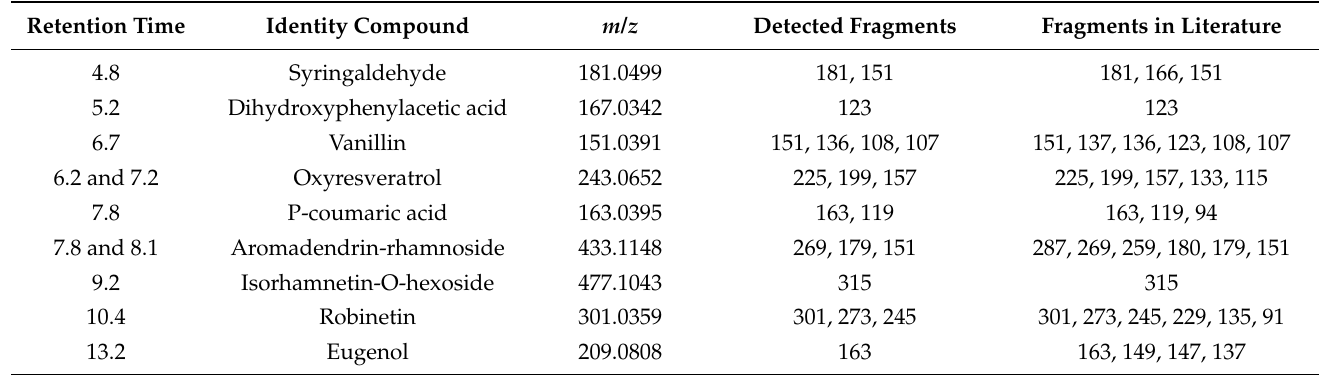
Table 3. Polyphenolic compounds identified with targeted analysis by MS but not detected by